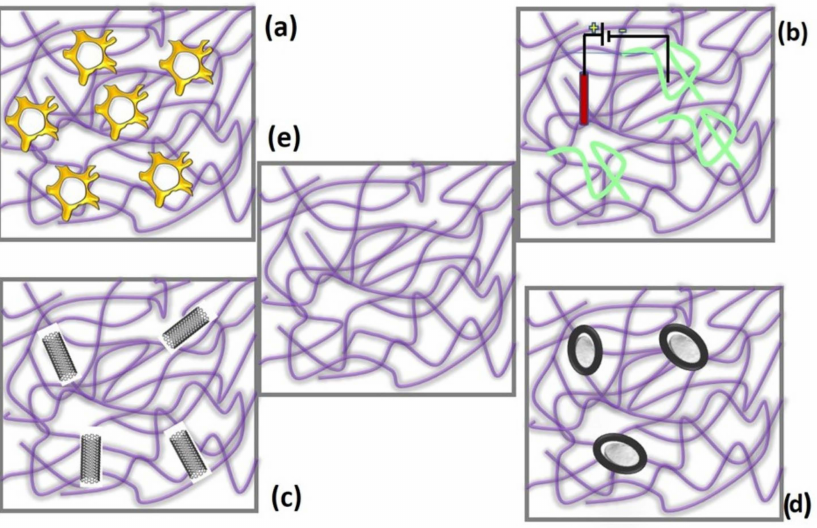
Figure 7. Various composite polymers that can form excellent compatibility with PAMPS for super- capacitor applications. ( a ) Dopant in 3D polypyrrole network formed by synergetic coupling with graphitic oxide and obtaining highest capacitance of 698.8F g − 1 at 5mV s − 1 [80]; ( b ) Hydrous ruthe- nium oxide (RuO 2 ) adopted with PAMPS with electrodeposition method and provide specific capaci- tance of 642 F g − 1 at 20 mV s − 1 [81]; ( c ) nanocomposites’ hydrogel electrodes PAMPS/multiwalled carbon nanotubes (MWCNTs) at various weight percentages, providing maximum energy density of 43.8 Wh kg − 1 at a power density of 520 W kg − 1 [82]; ( d ) preparation of supercapacitors with the composite of PVA/PAMPS, which provided a capacitance of 156.2 F g − 1 at temperatures of 80 ◦ C [83]; and ( e ) pure